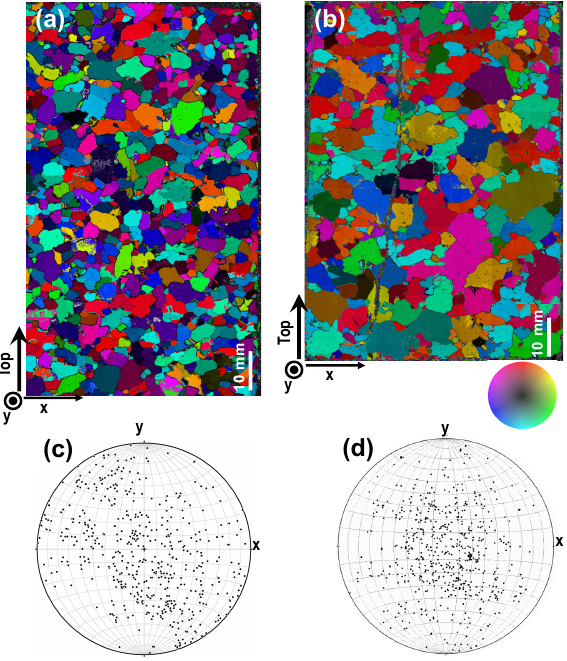
Figure 2. General appearance of the c-axis microstructure of (a) EDML microstructures at 655.5m of depth and (b) NEEM at 718.2m of depth. The orientation of the c-axes is shown by the coloured disc (the central grey colour indicates a c-axis that is ver- tical to the plane of the image). Panels (c) and (d) show pole figures of the c-axes for individual grains (one point per grain), 525 grains for the EDML sample and 601 grains in the NEEM sample. Please note that pole figure projection (equal area, lower hemisphere) fol- lows the glaciological convention of looking down on the core axis (top) from